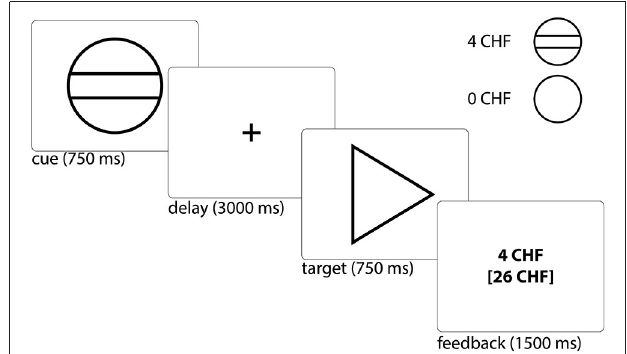
FIGURE 1 | Monetary incentive delay task: Example trial and cues representing possible reward outcomes . Participants first saw a cue stipulating with an unpredictable probability the amount of money (4 CHF or 0 CHF) they could win, if they reacted correctly within 750 ms during the ensuing discrimination task, which involved pressing either a left or right button depending upon the direction of a triangle after an anticipation period (variable delay: 2500–3500 ms, mean of 3000 ms). Immediately after target presentation, subjects were informed about the amount of money they had won during this trial and their cumulative total win so far (feedback) for a total of 1500 ms (Abler et al., 2005). The jittered inter-trial interval (ITI) was between 1000 and 8000 ms with a mean of 4000 ms. Trial types were randomly